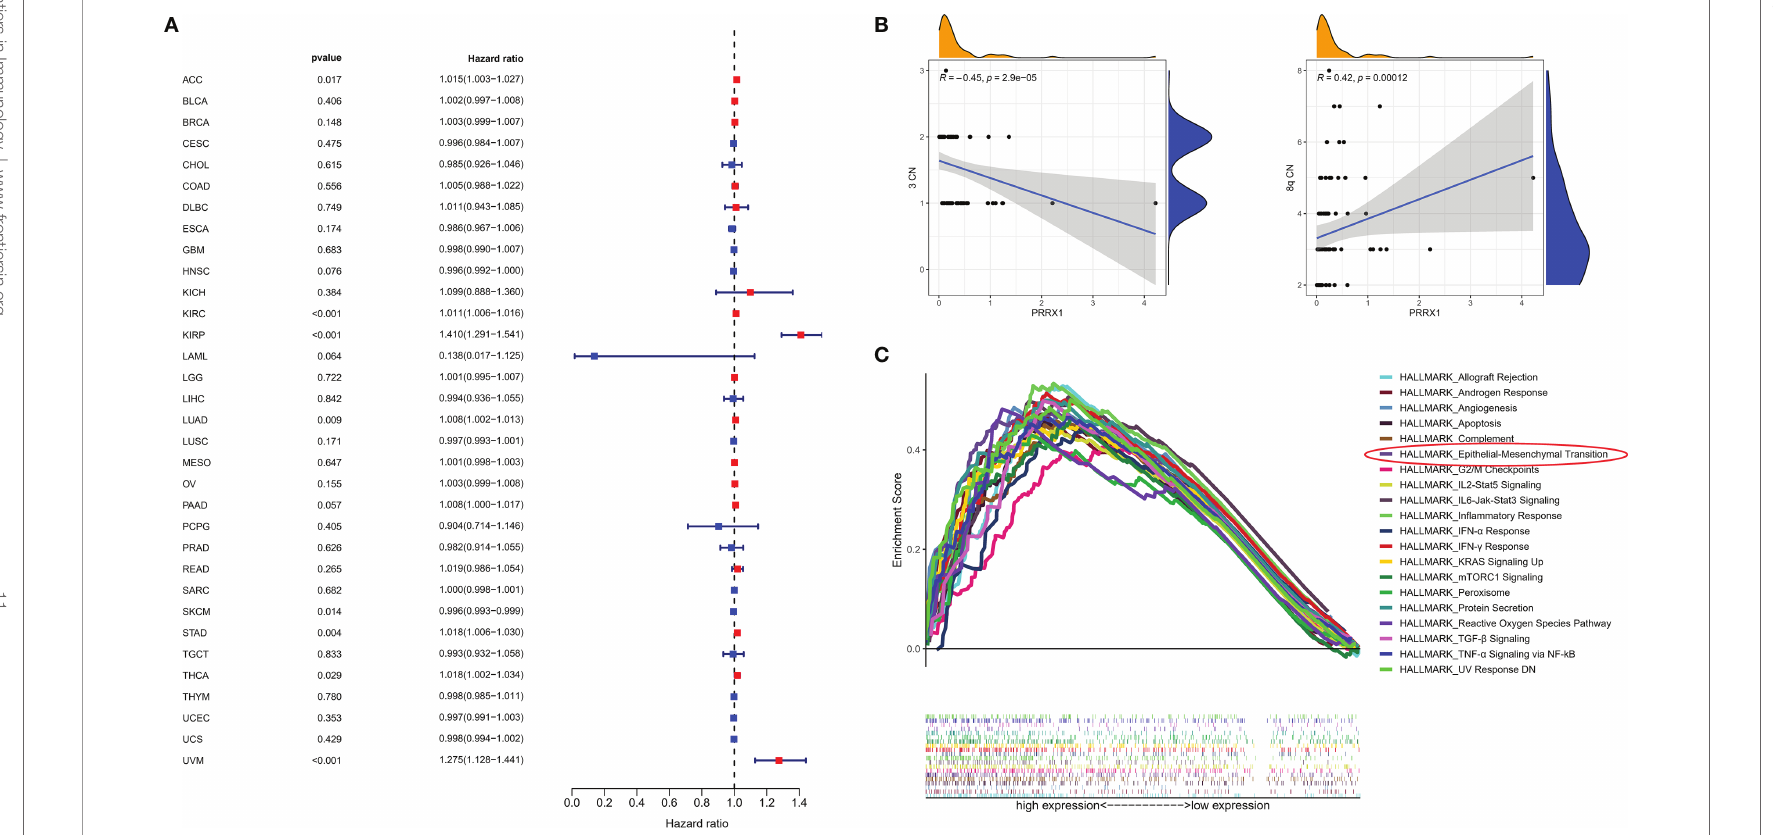
FIGURE 7 | (A) Association between PRRX1 expression level and OS in patients with 33 types of cancer from the TCGA database, red dots represent the possible risk factors while blue represents potential protective factors, abbreviations for all cancer types are in Table S4 . (B) Correlations between PRRX1 expression and chromosome 3/8q copy number, the density curve on the x and y-axes represents the distribution trend of themselves. The blue line indicates the best fi tted linear models and the shaded area indicates the 95% con fi dence interval. (C) GSEA plot of the top 20 ranked Hallmark sets of genes associated with high PRRX1 expression, as determined by comparing high and low PRRX1 expression groups (FDR < 0.25, p <